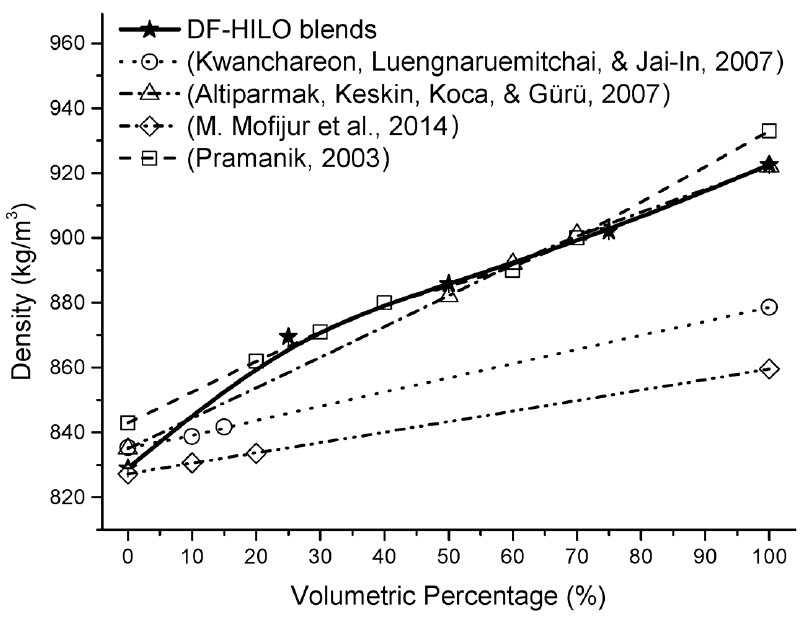
Figure 5. Densities of DF-HILO fuel blends [47–49,50].